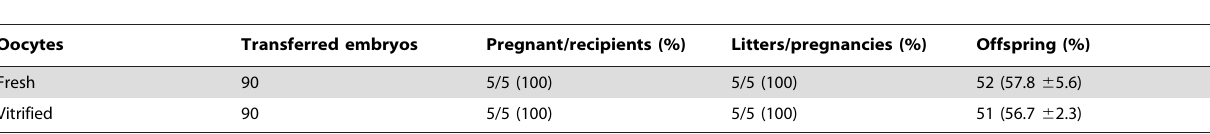
Table 1. In vivo development of vitrified COCs from C57BL/6J mouse after in vitro fertilization.